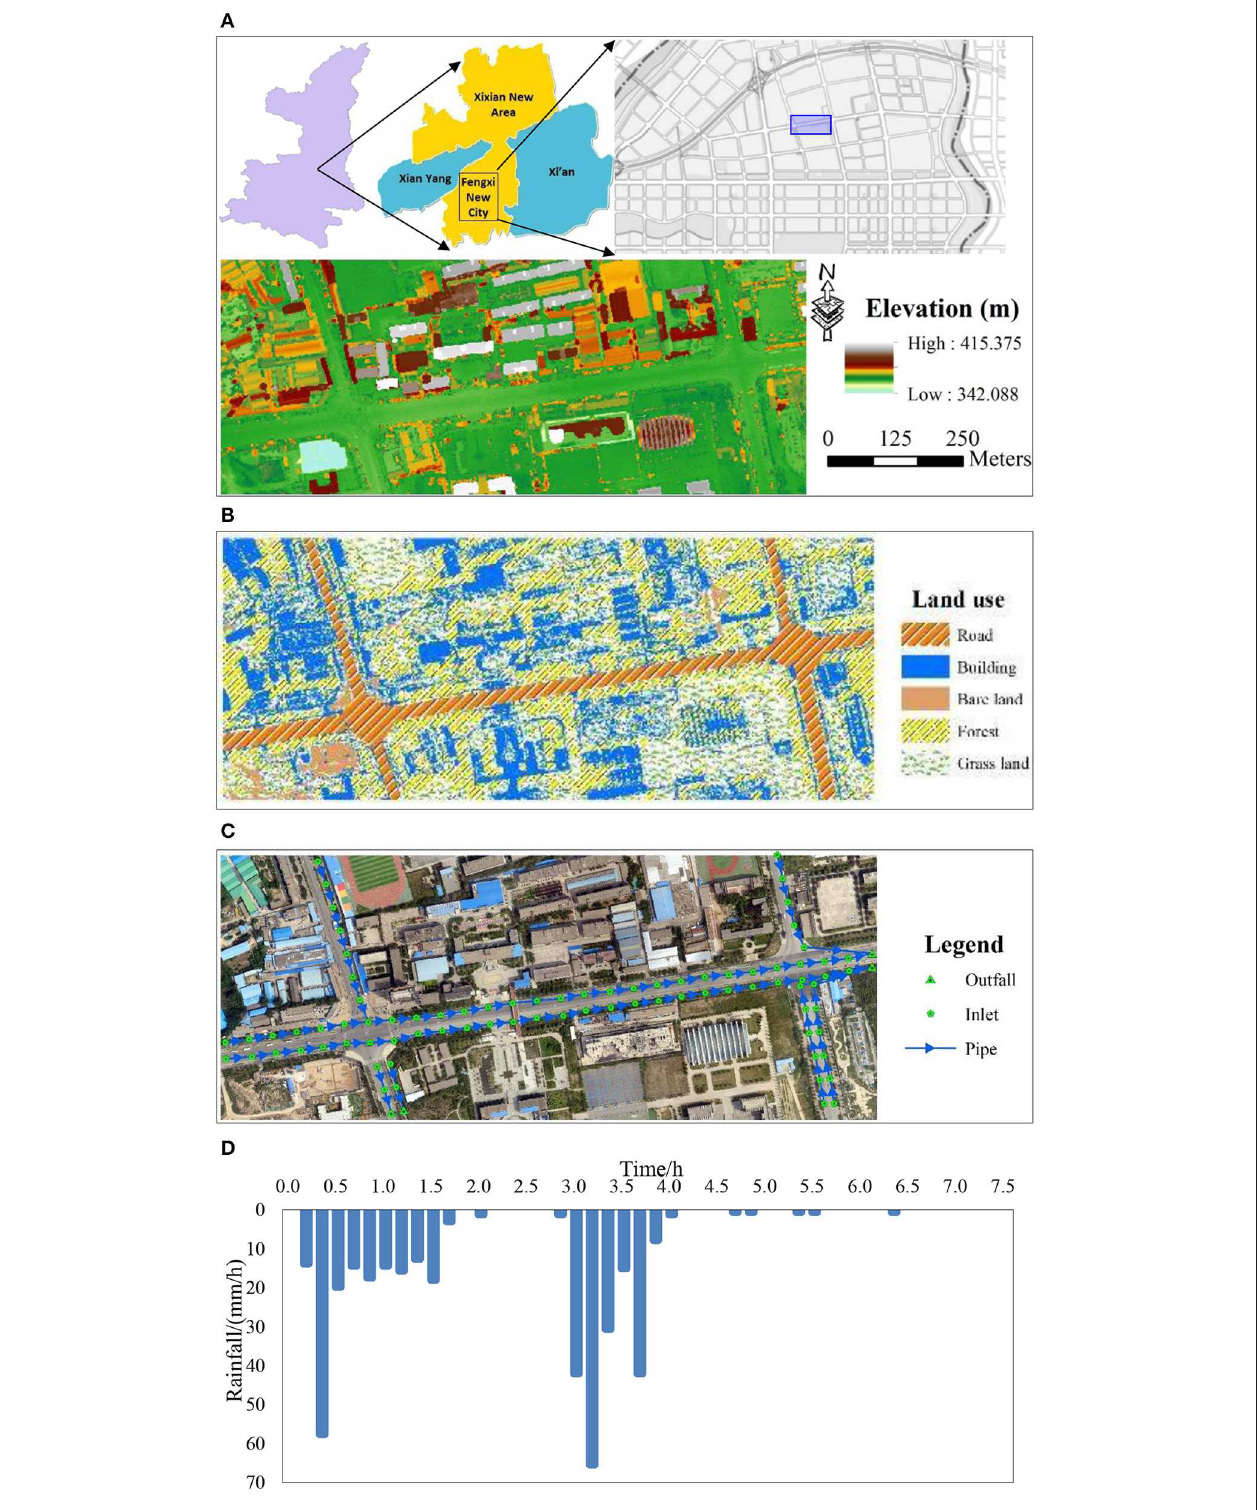
FIGURE 9 | Study catchment in Fengxi New City, Xixian New Area, China. (A) Digital Elevation Model (DEM); (B) land use map; (C) digital orthophoto map and the drainage-pipe layout; (D) hyetography in the study area.